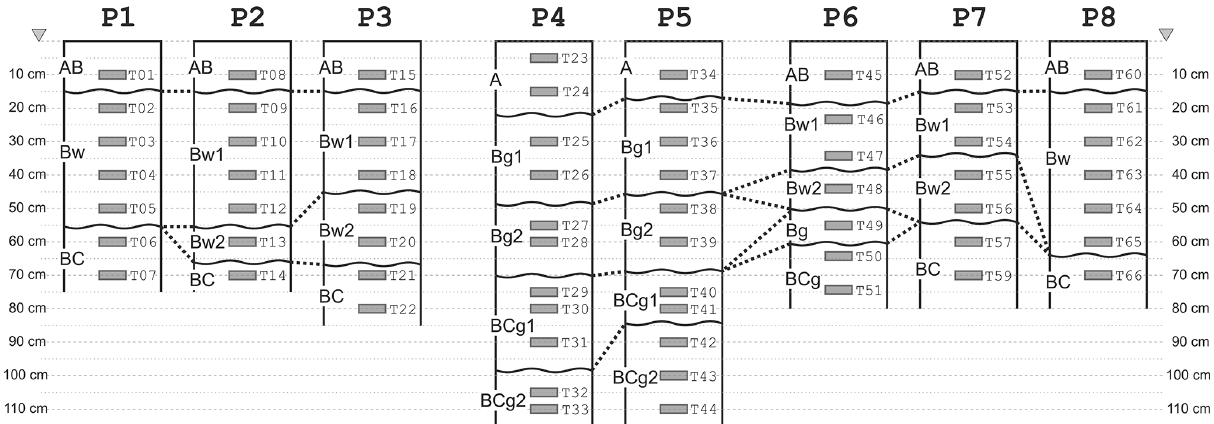
Figure 3. Sketch of the soil profiles (showing the mapped soil horizons according to WRB 2015) and the depth of the TDR probes (see